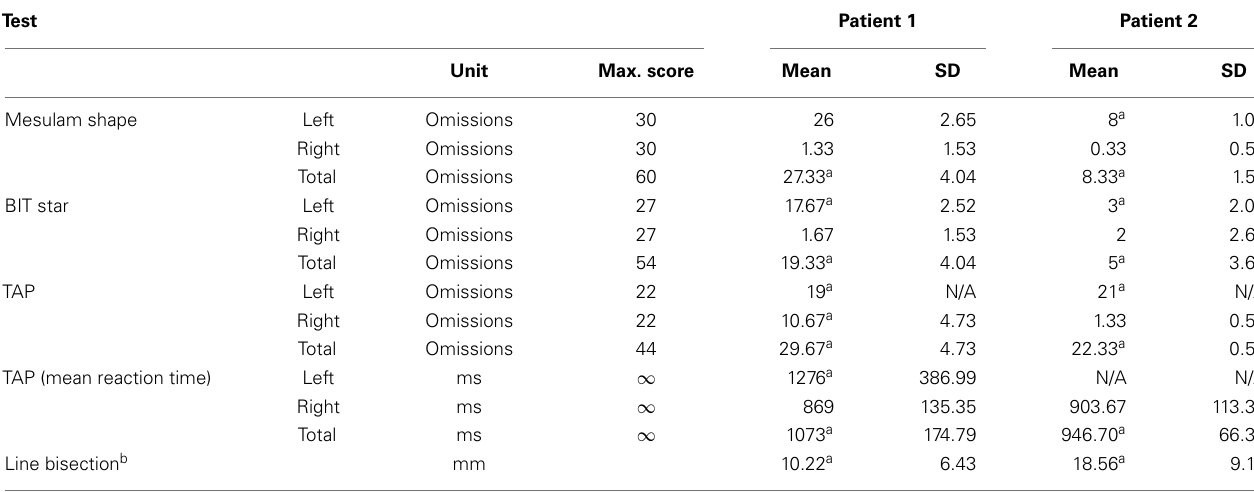
Table 1 | Baseline descriptive statistics